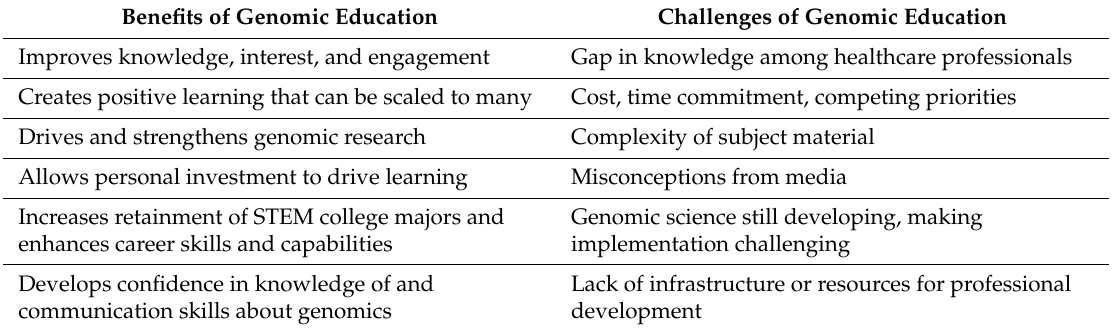
Table 2. Benefits and challenges in incorporating genomic education into academic, professional, and public